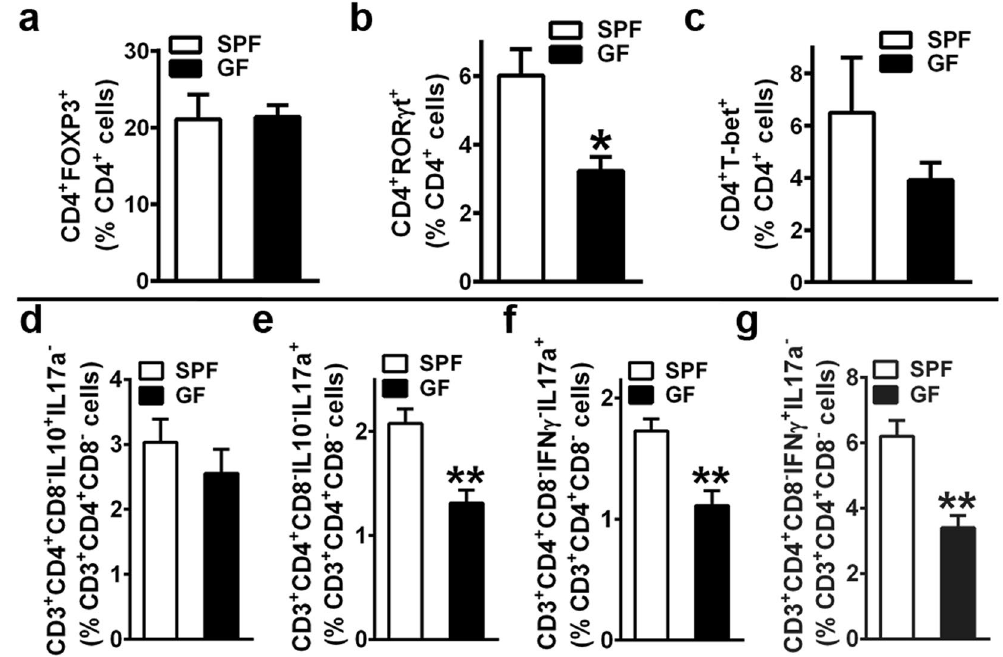
Figure 6. Bone marrow effector CD4 + T-cell hematopoiesis. ( a – c ) Marrow Transcription Factor Expression Assays: 12 week-old male SPF & GF mice were euthanized; femoral bone marrow cells were isolated and stained (n = 4/gp) for flow cytometric analysis to assess ( a ) % CD4 + FOXP3 + (T REG ) cells, ( b ) % CD4 + ROR γ t + (T H 17) cells, and ( c ) % CD4 + T-bet + (T H 1) cells. Percentages are expressed relative to CD4 + cells. ( d – g ) Marrow Intracellular Cytokine Expression Assays: 11 week-old gender matched (2 male and 2 female per group) SPF & GF mice were euthanized; femoral whole marrow was plated overnight for cytokine activation (PMA, Ionomycin, Monensin). Cells were isolated and stained (n = 4/gp) for flow cytometric analysis to assess ( d ) % CD3 + CD4 + CD8 − IL10 + IL17a − (CD4 + IL10 + ) cells, ( e ) % CD3 + CD4 + CD8 − IL10 − IL17a + (CD4 + IL17a + ) cells, ( f ) % CD3 + CD4 + CD8 − IFN γ − IL17a + (CD4 + IL17a + ) cells, and ( g ) % CD3 + CD4 + CD8 − IFN γ + IL17a − (CD4 + IFN γ + ) cells. Percentages are expressed relative to CD3 + CD4 + CD8 − cells. Data are reported as mean ± SEM. * p < 0.05 vs. SPF; ** p < 0.01 vs.